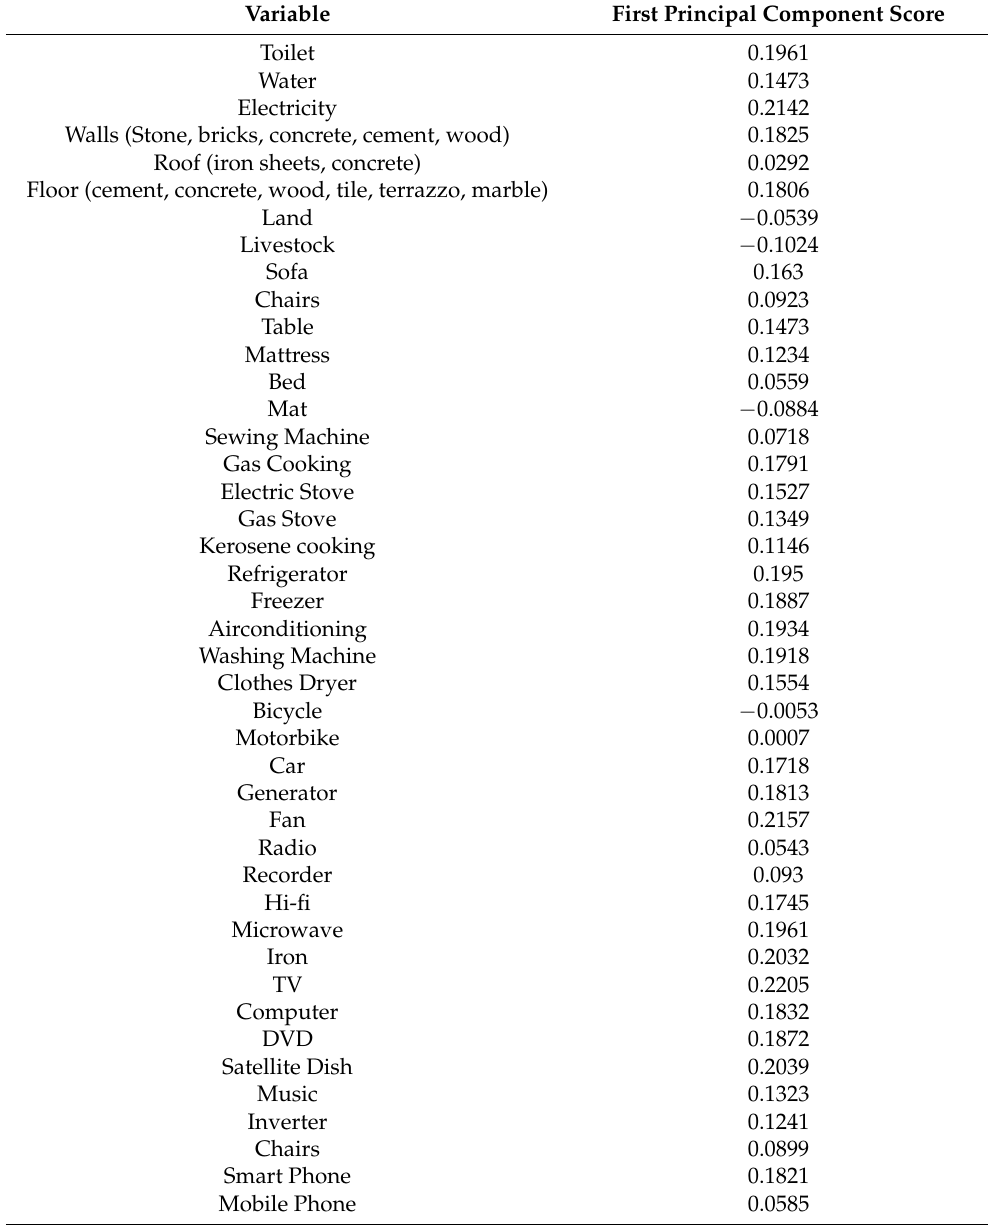
Table A6. Asset index for Nigeria—Results from tetrachoric Principal Components Analysis.